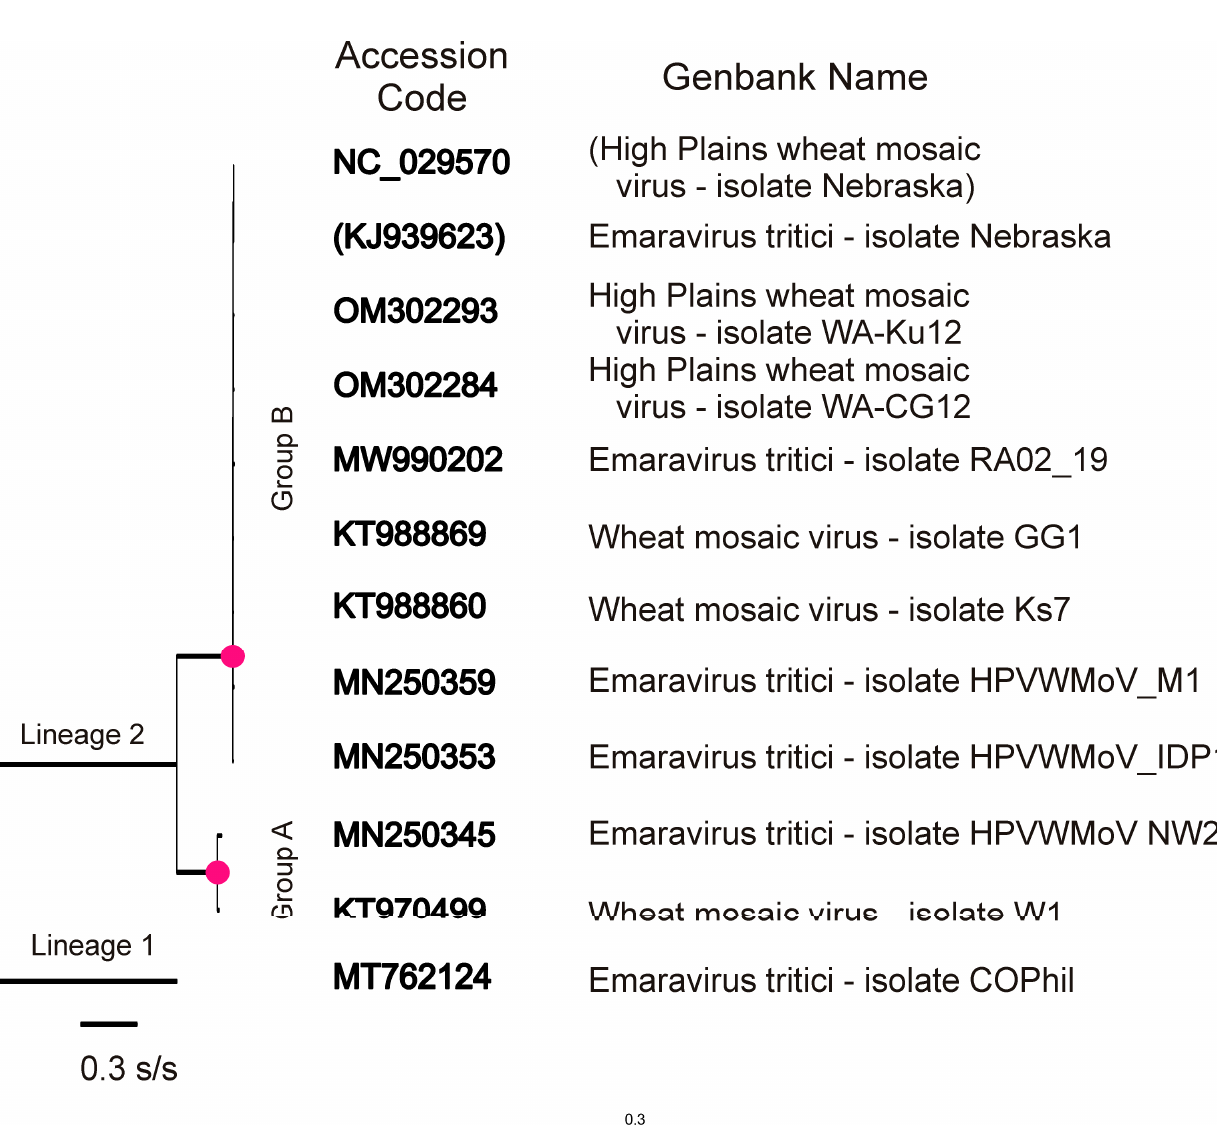
Figure 2. The ML phylogeny of the non-recombinant nucleotide sequences of 12 HPWMoV RNA1 ORFs. The geographical origins of these 12 sequenced isolates were: Western Australia (OM302293,